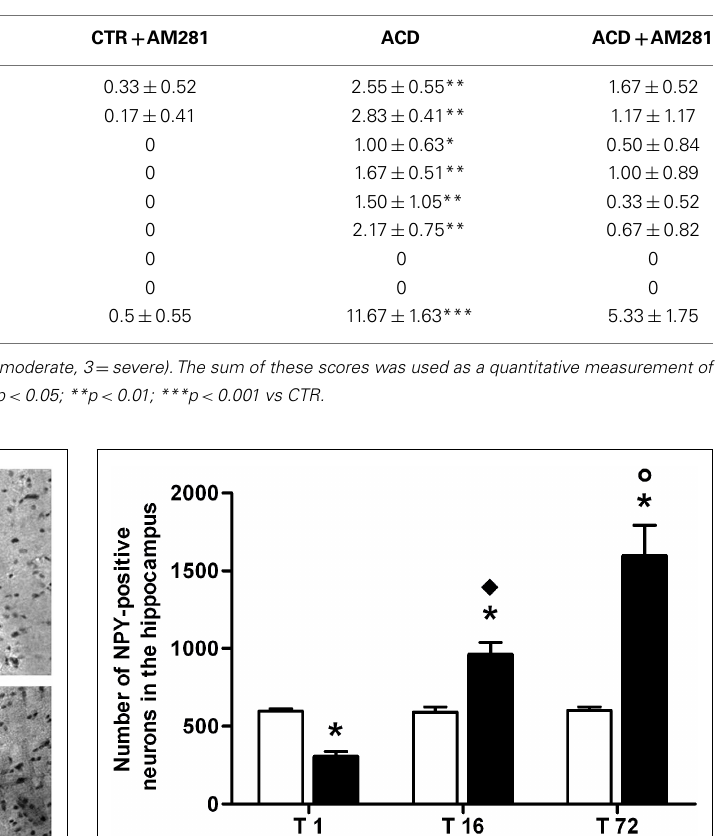
Table 1 | Behavioral observations of withdrawal .